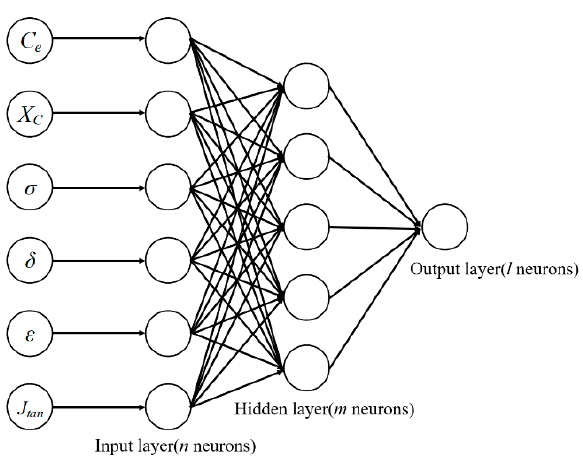
Figure 6. Structure of Backpropagation (BP) neural network.